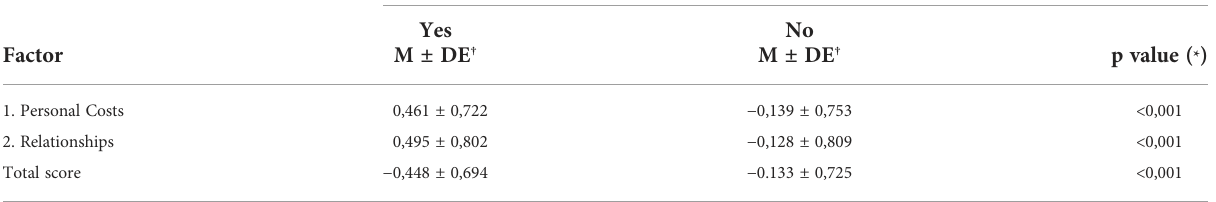
TABLE 3 Criterion validity by comparing groups according to adherence to the Pap test.